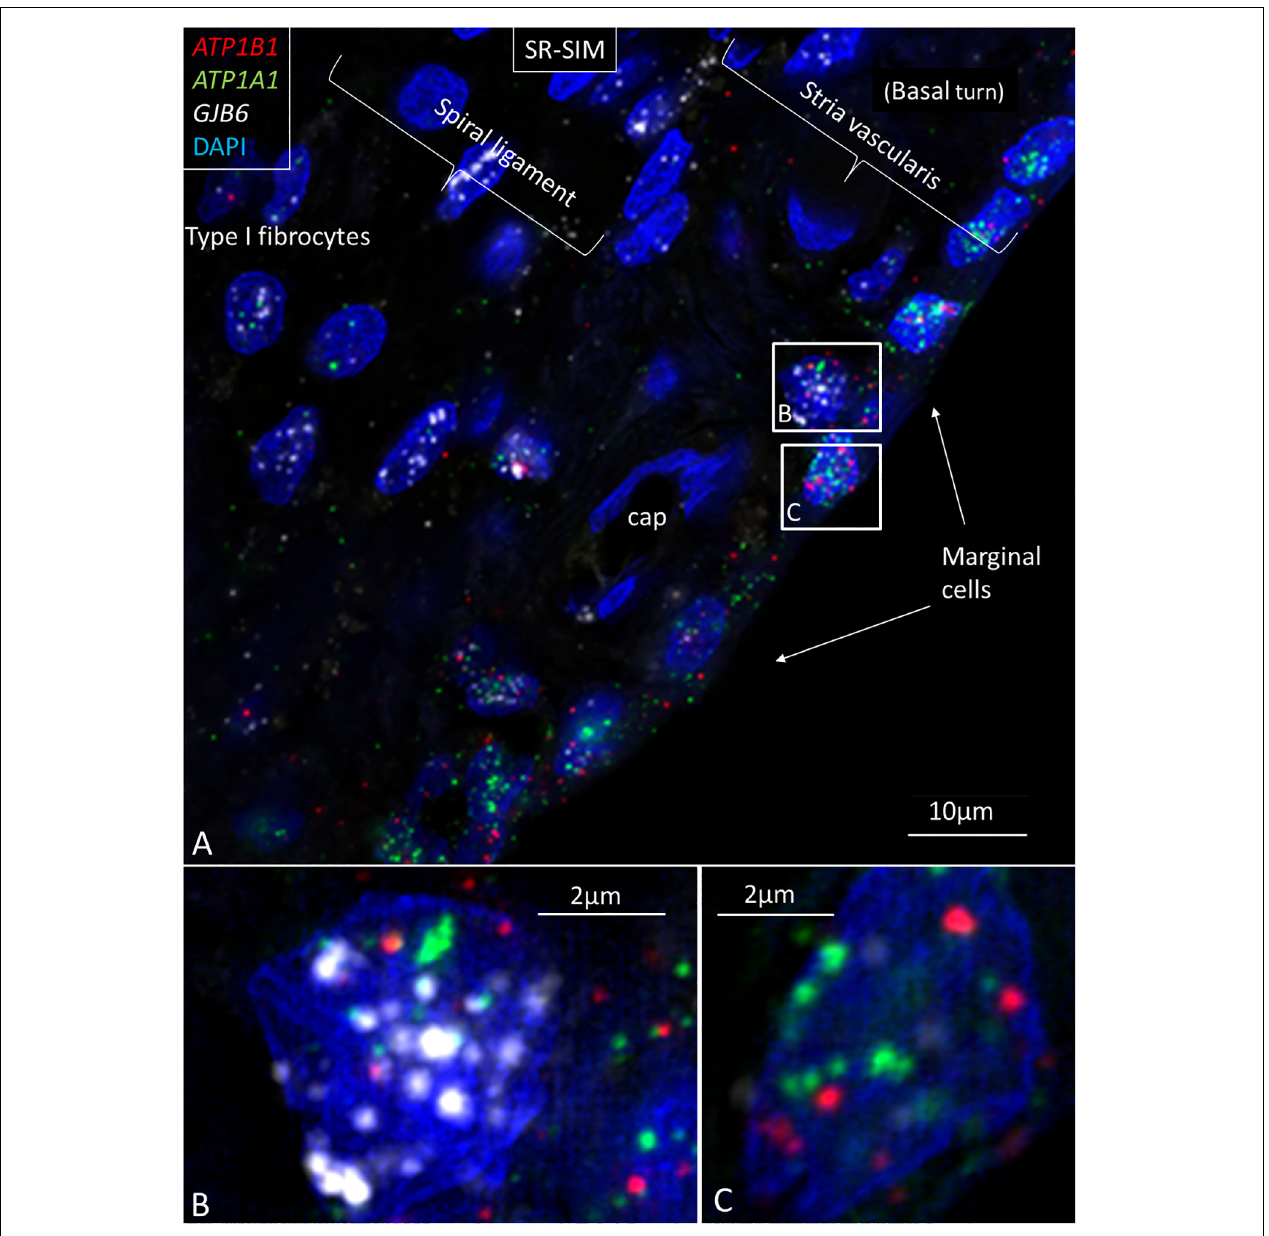
FIGURE 3 | Multiplex RNAscope R (cid:13) shows ATP1A1 , ATP1B1 , and GJB6 gene transcripts in the lateral wall of the human cochlea. (A) Marginal cells express ATP1A1 and ATP1B1 genes, while basal and intermediate cells mainly express the GJB6 encoding the protein Cx30. A few cells also express single NKA gene puncta. A capillary in the SV contains no gene transcripts. (B) Framed cell in (A) is shown at higher magnification. The cell contains all three gene transcripts in the cell nucleus. (C) Framed marginal cell in (A) is shown at higher magnification. The nucleus contains ATP1A1 and ATP1B1 genes, but no GJB6. DAPI, 4 (cid:48) ,6-diamidino-2-phenylindole, a cell nucleus marker.